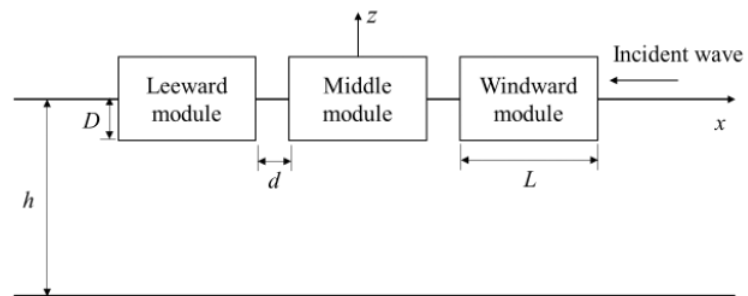
Figure 1. Sketch of the multi-module system.